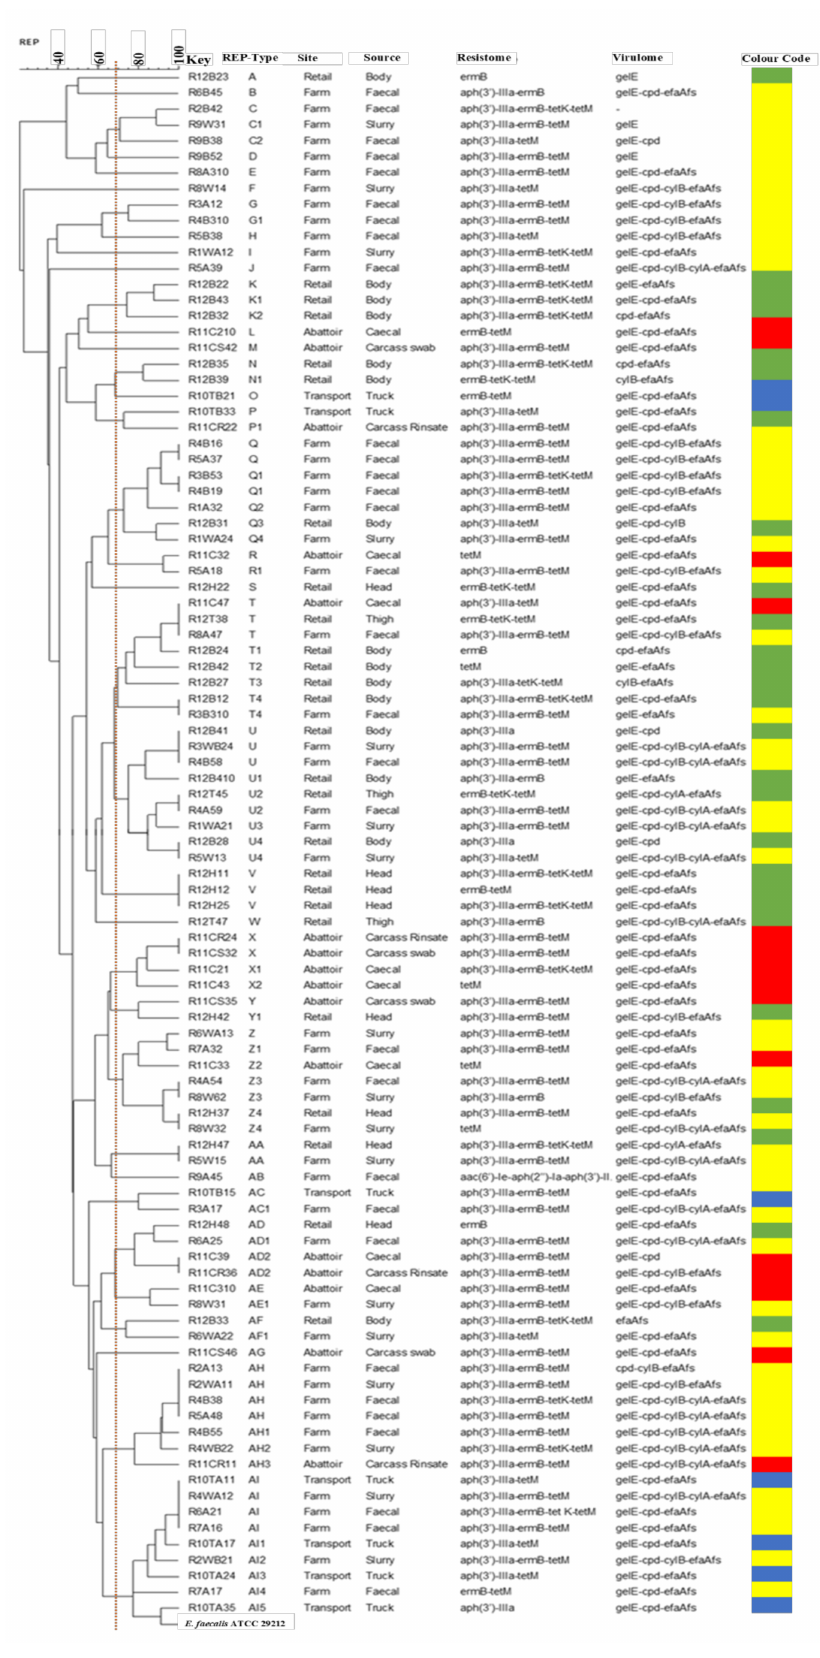
Figure 3. Dendrogram showing REP-types of E. faecalis isolates, based on ≥ 70% similarity index recovered along the farm-to-fork continuum. Farm = yellow, transport = blue, abattoir = red, retail = green. E. faecalis ATCC 29212 was used as the reference